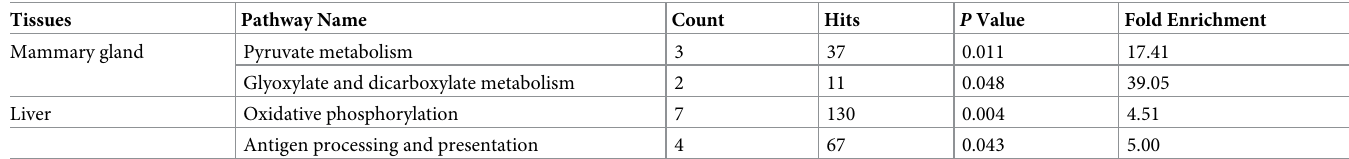
Table 2. Pathway analysis of differential expressed proteins from mammary gland and liver between heat-stressed and pair-fed cows.